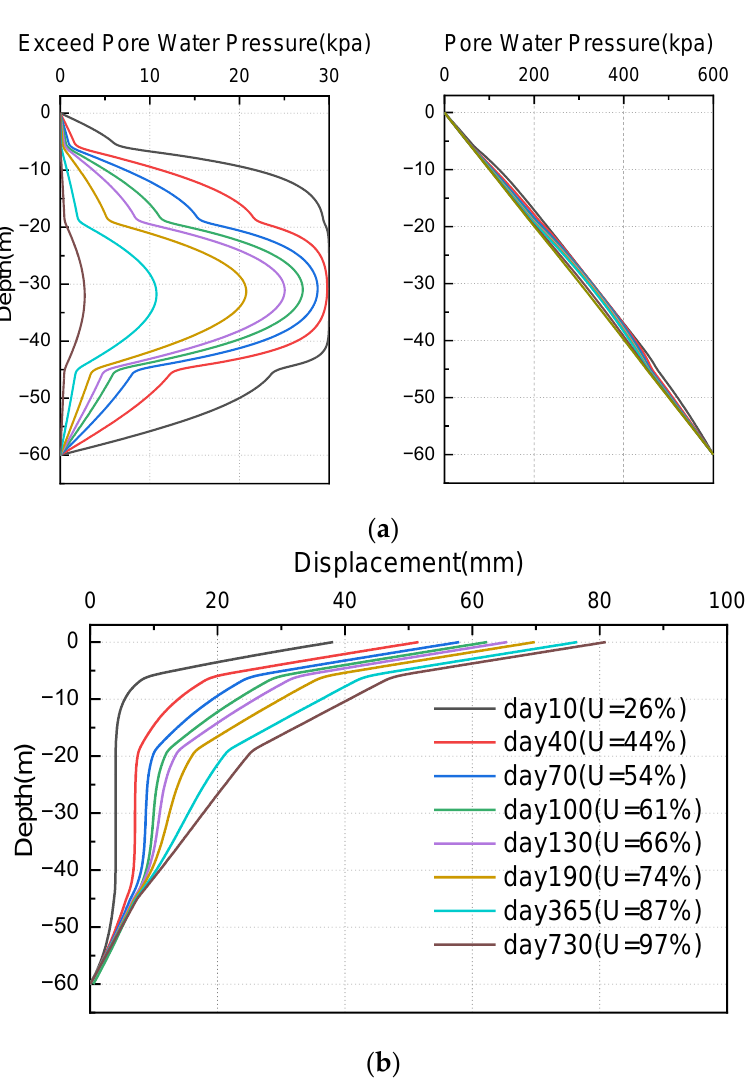
Figure 5. Effect of consolidation on pore water pressure and displacement. ( a ) Pore water pressure, ( b ) Soil displacement.